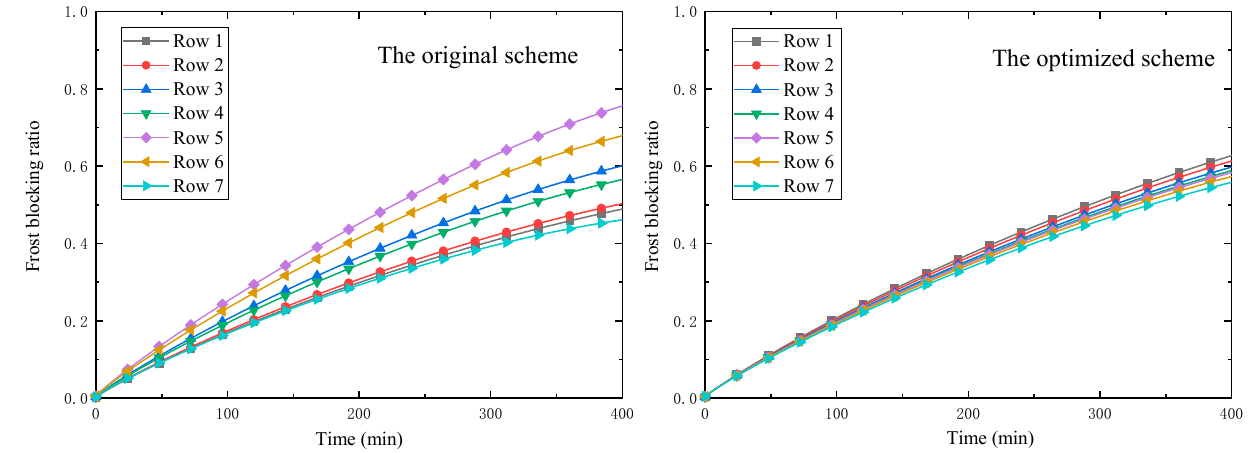
difference. The blockage ratio of the 1st row is the largest and that of the 7th row is the smallest, which is 62.8% and 55.8% at 400 min, respectively, with a difference of only 7%. This leads to a more uniform distribution of single-row pressure drop in Figure 9. Figure 9.